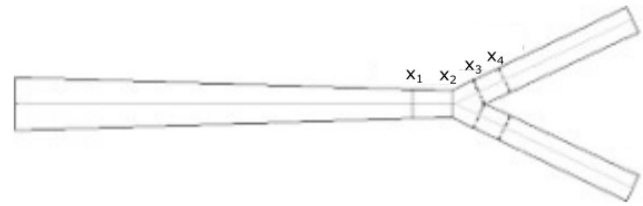
Figure 7. Relevant locations of the geometry.